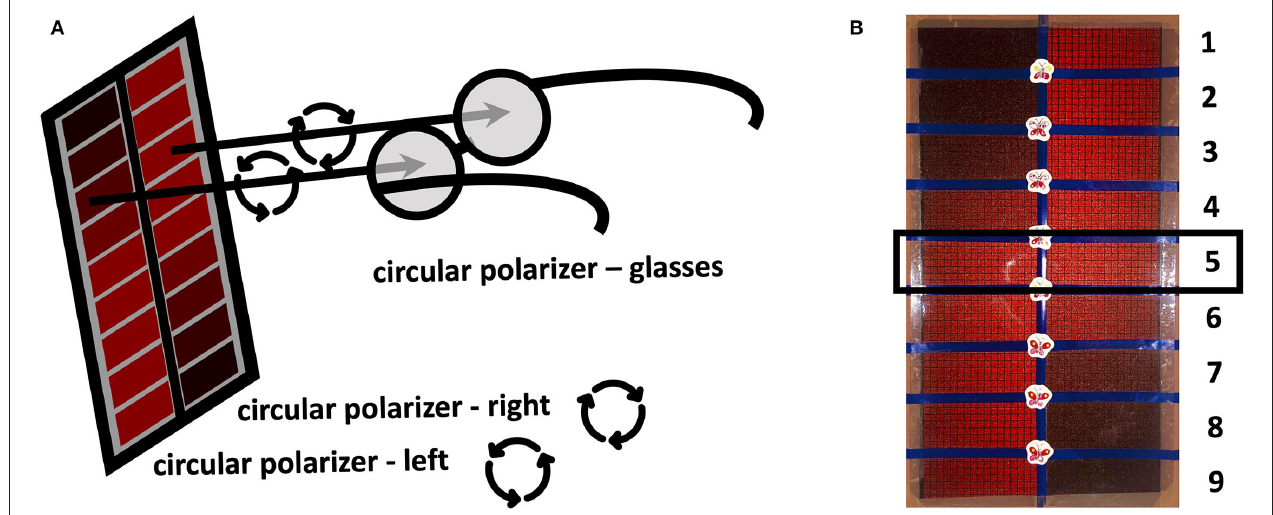
FIGURE 1 | Schematic illustration of the Reddesa chart (A) . The patient is wearing polarization glasses and holds the Reddesa test at reading distance. He/she has to identify the field on the left and right columns that appear to have the same red saturation. Photograph of the Reddesa test chart (B) . The graduations of the red color change gradually in the fields of two rows next to each other. The graduation in the middle (number 5) denotes no difference in the red desaturation of both